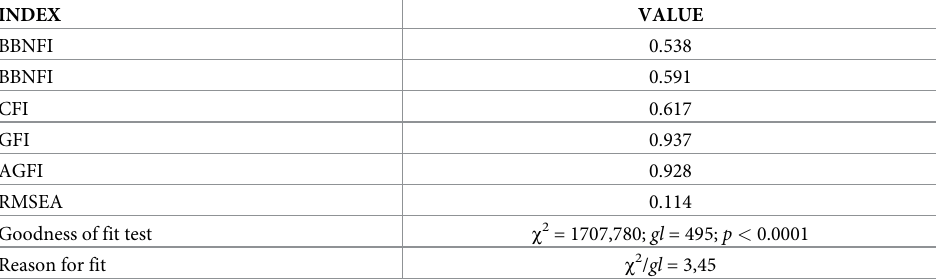
Table 2. Goodness-of-fit indexes for the confirmatory model W-DEQ-B-Sp.